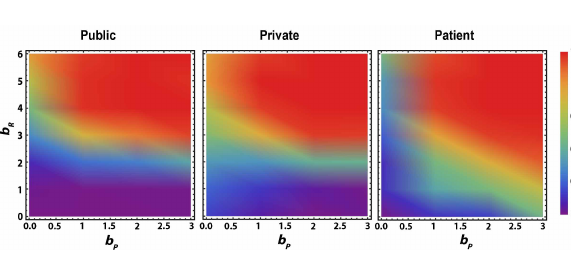
Figure 1. The cooperation level in each of the three populations as a function of the sectors’ benefit b and R patient’s benefit b . Other parameters: c P I , c T , c M = 1; N 1 , N 2 , N 3 = 100; ε = 0 . 2; µ = 10 − 4 ; β = 0 . 1